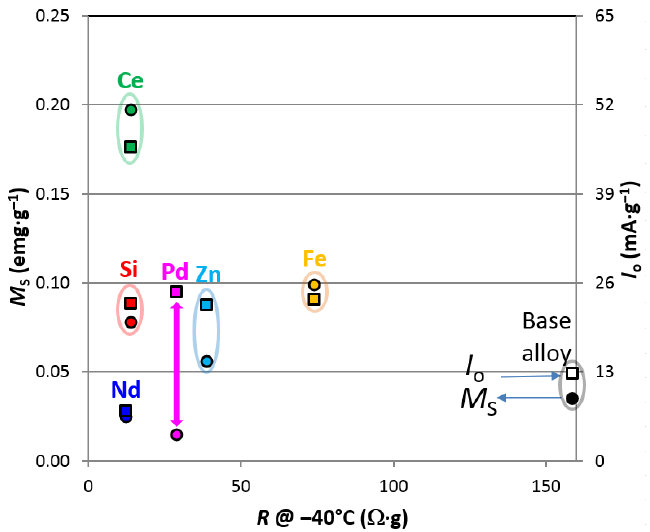
Figure 15. M S and I o measured at room temperature vs. surface reaction resistance R measured at − 40 °C are plotted for the base alloy (Ti 12 Zr 22.8 V 7.5 Mn 8.1 Co 7 Ni 32.2 Al 0.4 ) and alloys with additions of 1 at % Ce, Si, Pd, Zn, Fe, and Nd. All additives demonstrate a reduction in R measured at − 40 °C. The M S and I o pair from the Pd ‐ containing alloy shows the largest separation, suggesting that the amount of catalytic Ni embedded in the surface oxide is not the origin of the improvements in I o and R .